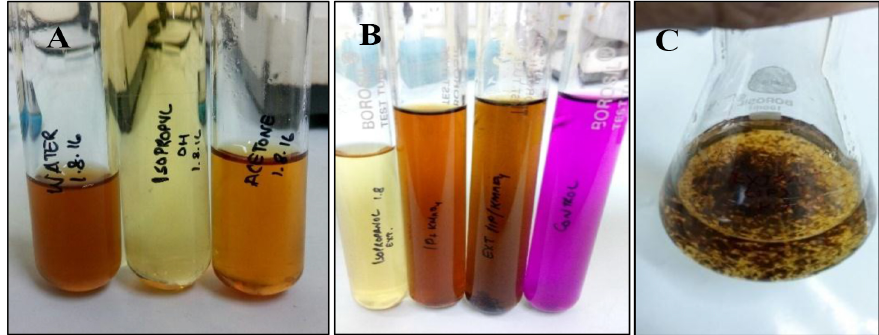
Fig. 1. (A) Solvent extraction, (B) synthesis of nanoparticle, (C) brown precipitation confirming synthesis of MnO2